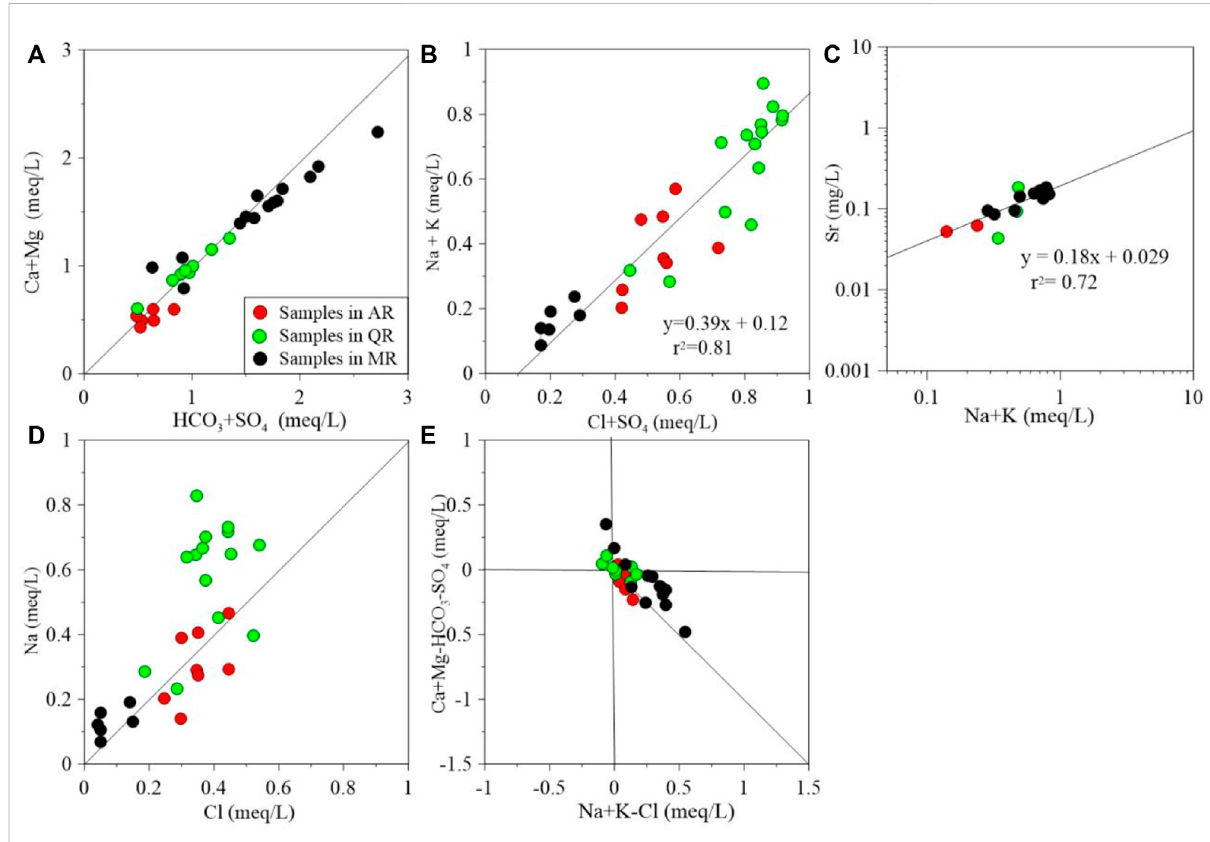
FIGURE 6 Bivariate diagrams of (A) (Ca + Mg) vs. (HCO 3 + SO 4 ), (B) (Na + K) vs. (Cl + SO 4 ), (C) Sr vs. (Na + K), (D) Na vs. Cl, (E) (Ca + Mg-HCO 3 -SO 4 )vs. (Na +